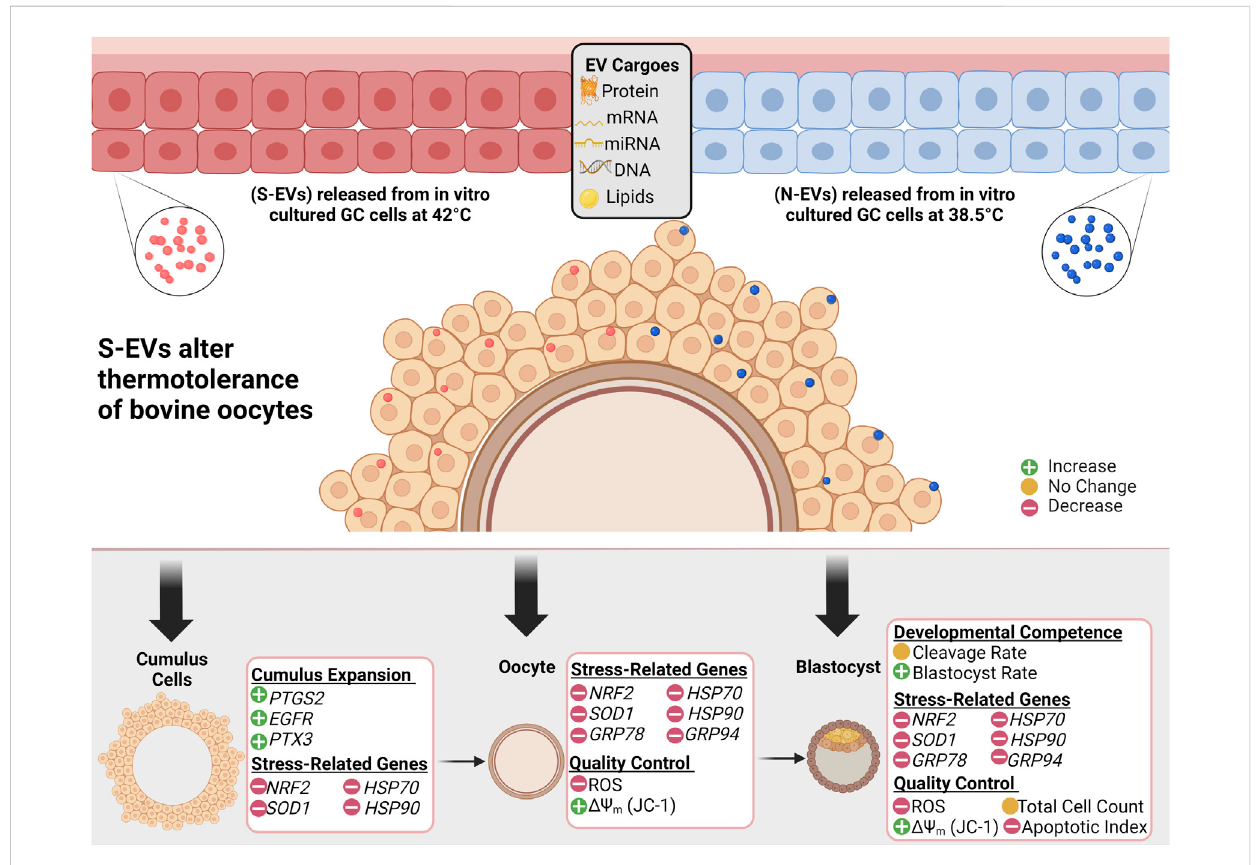
FIGURE 10 Graphical Synopsis. Schematic illustration showing EVs secreted from follicular granulosa cultured in vitro under 38.5 ° C (N-EVs) and 42 ° C (S-EVs), preferentially uptaken in the cumulus cells in intact cumulus-oocyte complexes following co-incubation during in vitro oocyte maturation. Results indicate that S-EVs effectively modulate the thermotolerance of bovine oocytes to elevated temperatures shown through the functional analysis conducted in the cumulus cells, oocytes, and developed